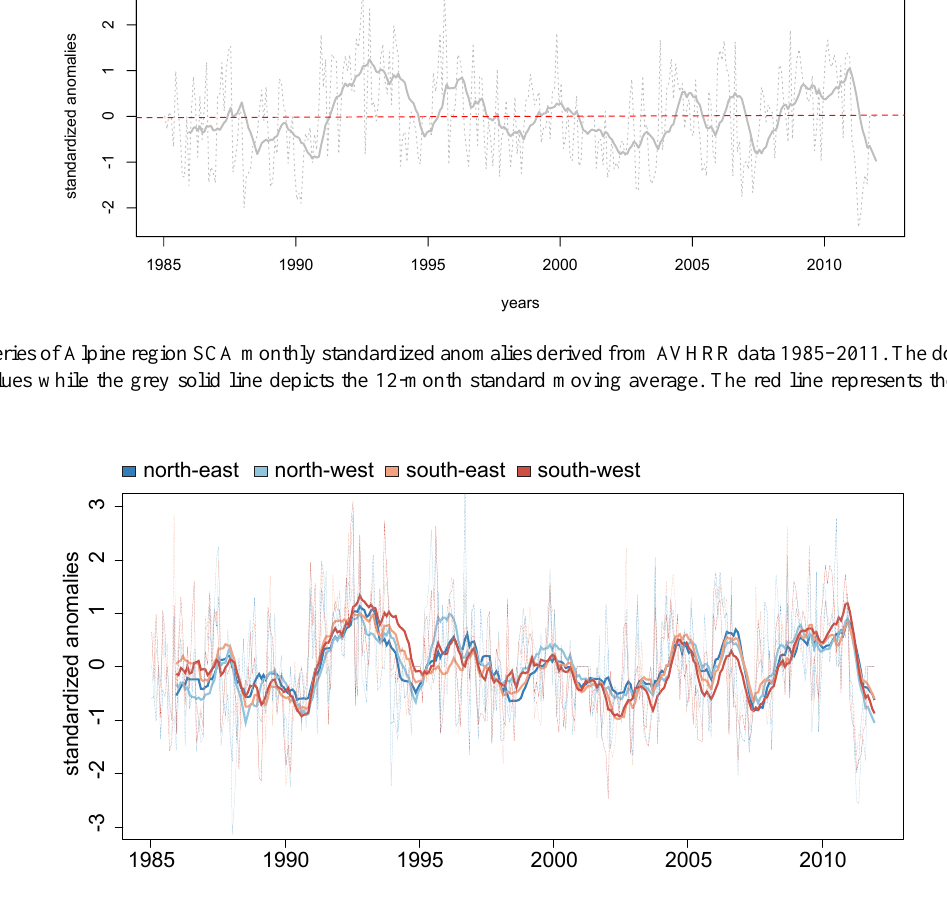
Fig. 12. Same as Fig. 11 but resolved into the four climatic regions.